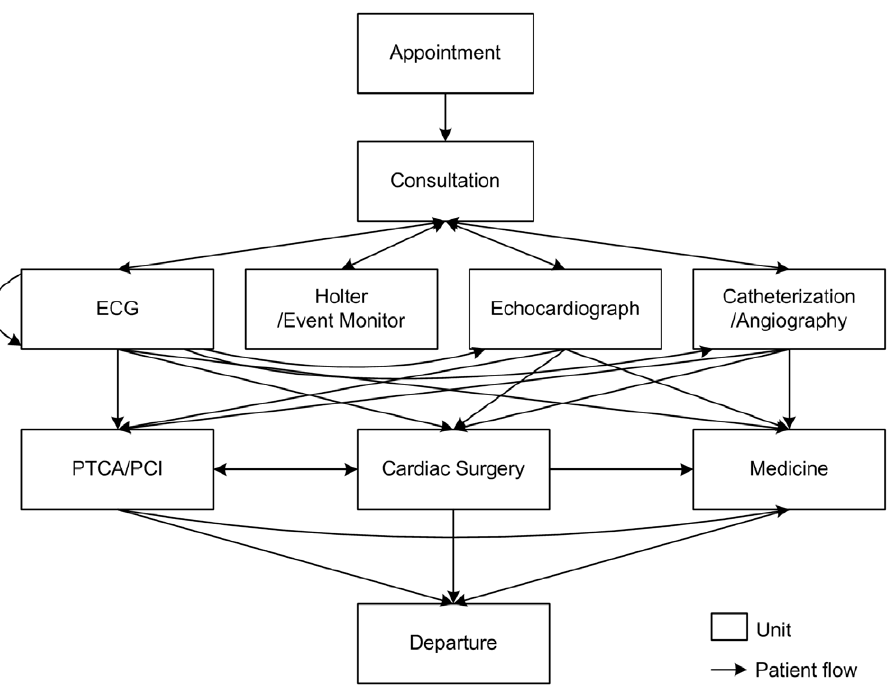
Figure 1. The unit framework of cardiac care drawn from the cardiac treatment guidelines [ 45 ][ 46 ]. (ECG: Electrocardiogram; PTCA: Percutaneous transluminal coronary angioplasty; PCI: Percutaneous coronary intervention.)